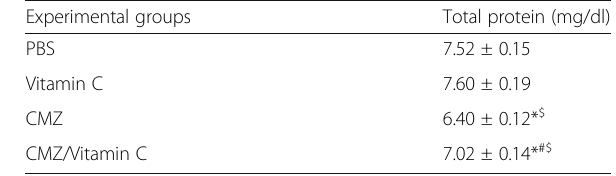
Table 5 Immunomodulatory activity in the serum of male Swiss albino mice treated with PBS, vitamin C (1136 μ M/kg), CMZ (46 μ M/kg), or a combination of CMZ and vitamin C with the same dose of each intraperitoneally (i.p.) daily over 4 weeks